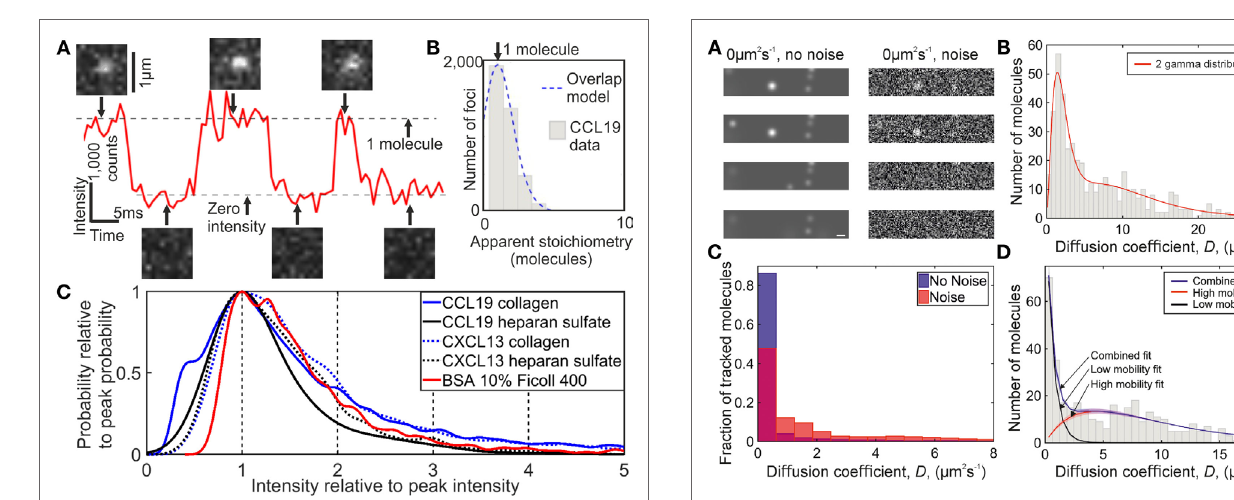
FigUre 2 | Single-molecule stoichiometry of CCL19-AF647. (a) Tracking of photoblinking Alexa Fluor 647 (AF647): localizations and intensity over time with sample images from the acquisition. (B) Distribution of apparent CCL19 foci stoichiometry (gray) overlaid with the predicted distribution based on randomly overlapping point spread functions (blue). (c) Kernel density estimates of intensity of AF647 labeled CCL19 in collagen (solid blue line), and under heparan sulfate immobilization (solid black line); CXCL13 in collagen (dotted blue line), and under heparan sulfate immobilization (dotted black line); and bovine serum albumin in 10% Ficoll (solid red line). All traces are normalized to the primary peak for clarity (see Supplementary Material).